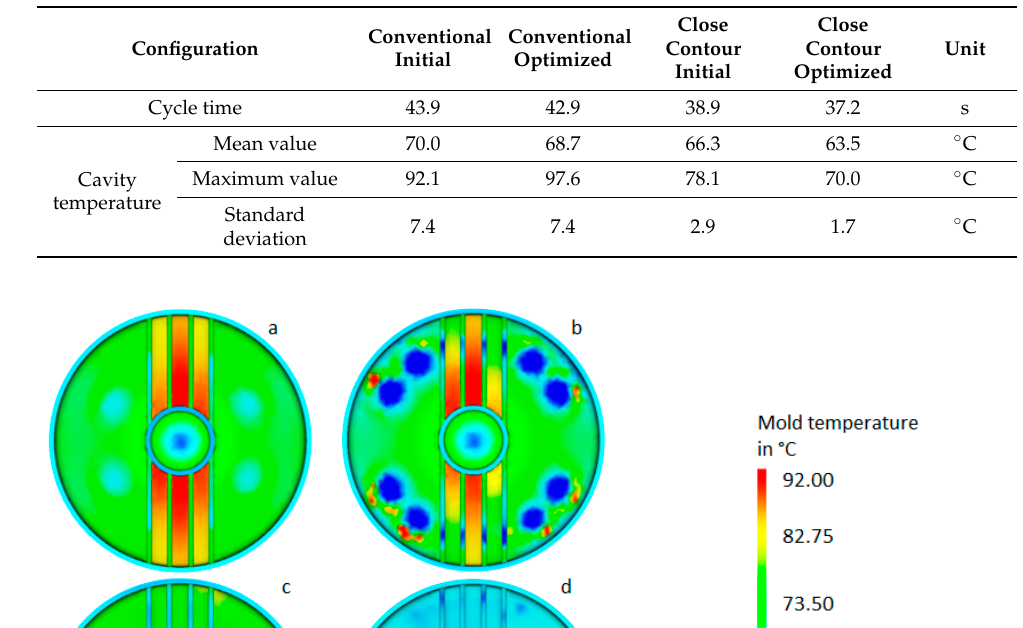
Table 8. Comparison of the simulation results for the initial and optimized conventional configura- tions ( left ) with the initial and optimized close-contour configurations ( right ).